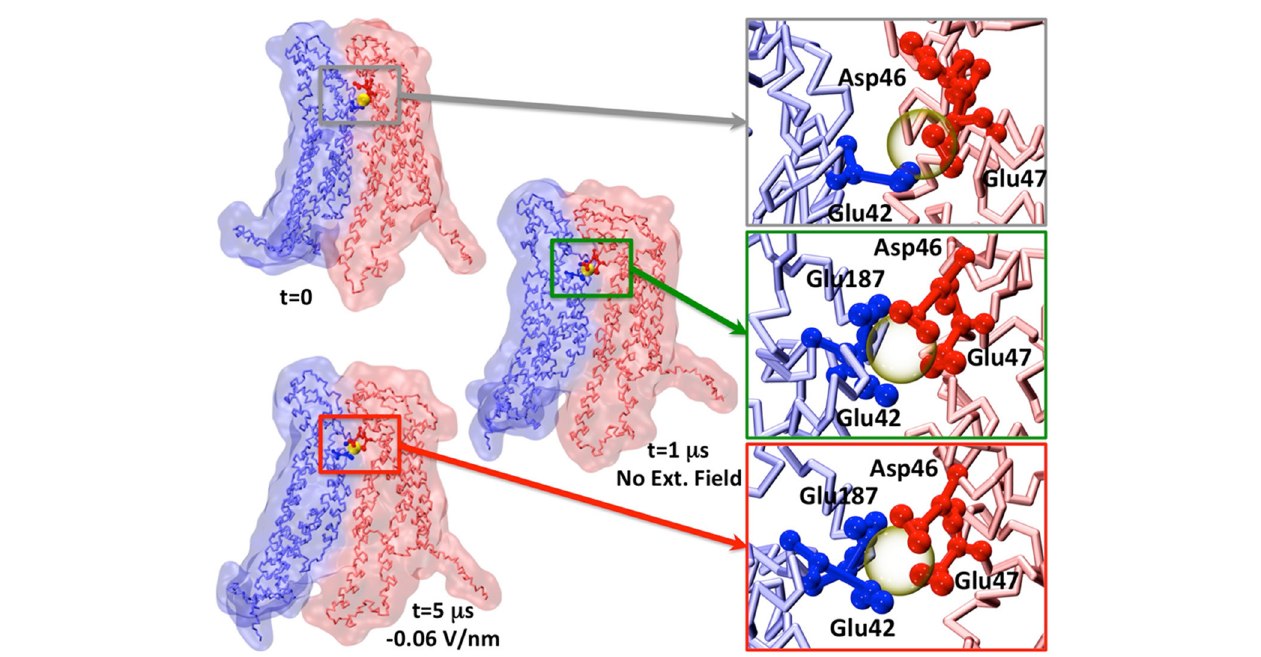
FIGURE 5 | Representative snapshot of two apposed connexins coordinating one Calcium ion. The insets show the change in Calcium coordination. For the sake of visual clarity, only the amino acids within 0.5nm of Calcium (semitransparent yellow sphere) are shown and colored by chain.